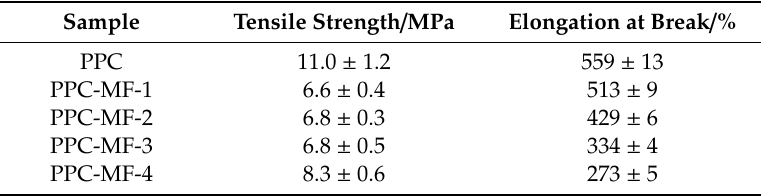
Table 2. The tensile results of PPC and